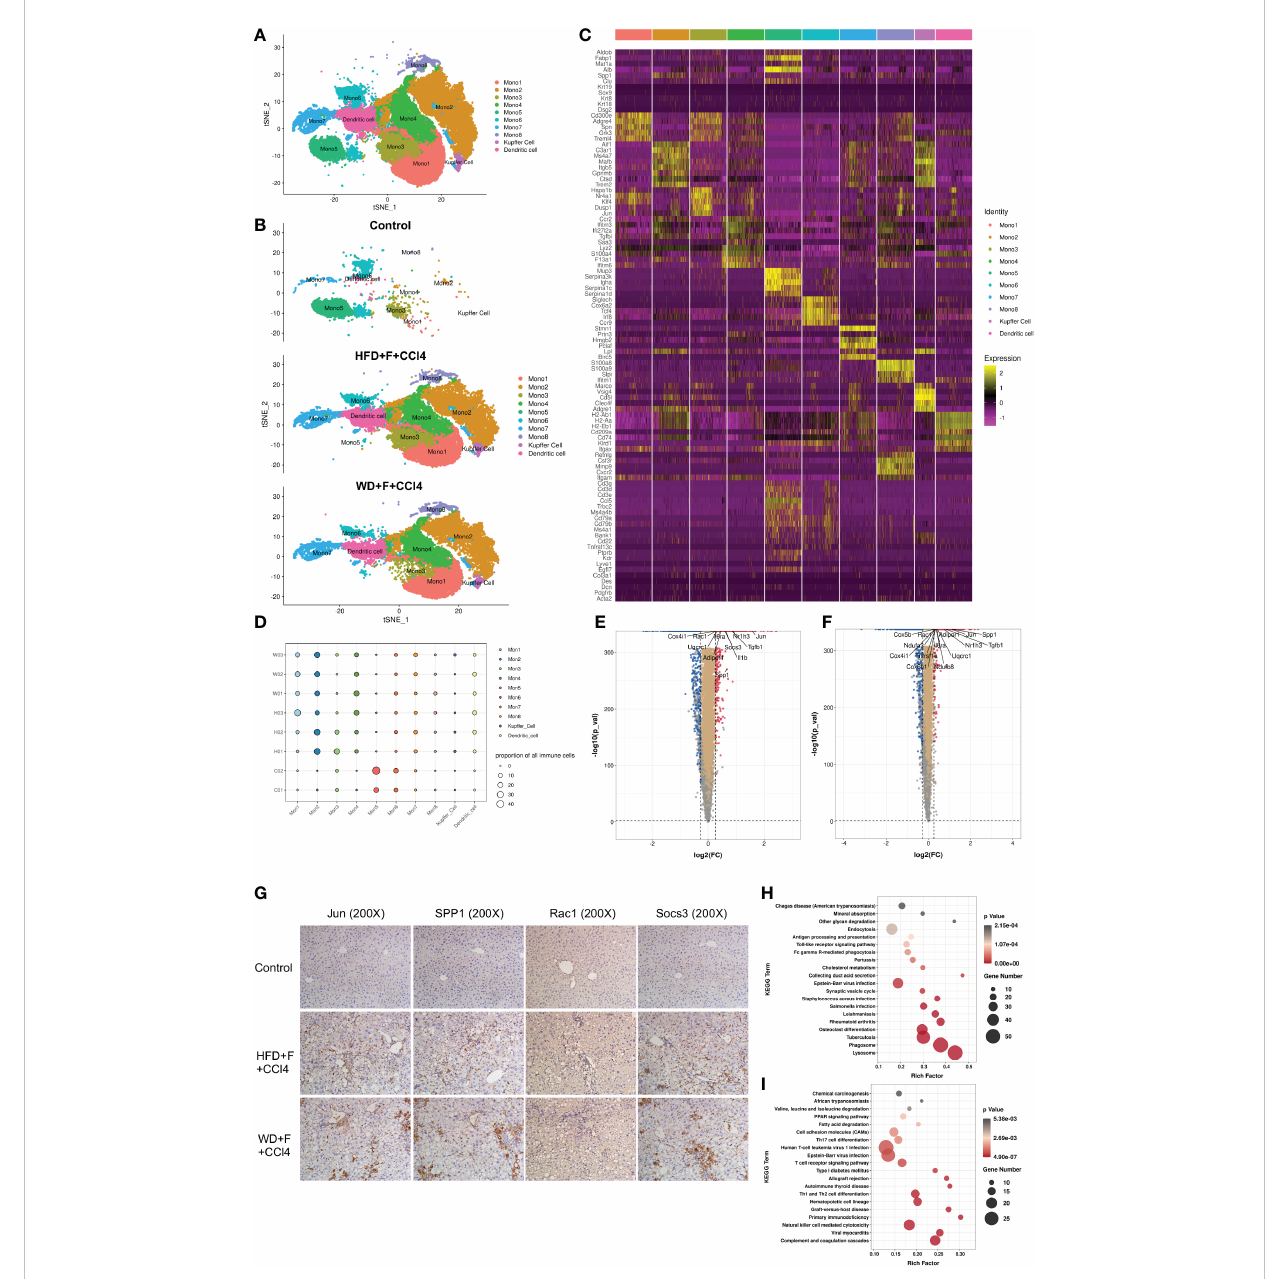
FIGURE 3 The components of the monocyte-macrophage cell-DC (MMD) system in normal and NASH mice with fi brosis. (A, B) t-SNE plot showing the subtypes of cells in the MMD system from normal and NASH mice with fi brosis. Each cluster is color-coded according to cell type and mouse group. (C) Heatmap showing the expression of the marker genes in each cell type of the MMD system. (D) Bubble map showing the proportion of each cell type in the MMD system from normal and NASH mice with fi brosis. (E, F) Volcano plot showing the differentially expressed genes in the MMD system between control and HFD+F+CCl4 mice/control and WD+F+CCl4 mice. (G) Representative images of IHC staining (Jun, SPP1, Rac1 and Socs3) in formalin- fi xed paraf fi n-embedded (FFPE) tissue in control, HFD+F+CCl4 and WD+F+CCl4 mice. (H, I) Bubble plot showing the KEGG enrichment of speci fi c pathways in monocyte 2 (Mono2) and Mono5. ps: C01-02: control mice 01-02; H01-03: HFD+F+CCl4 mice 01-03; W01-03: WFD+F+CCl4 mice